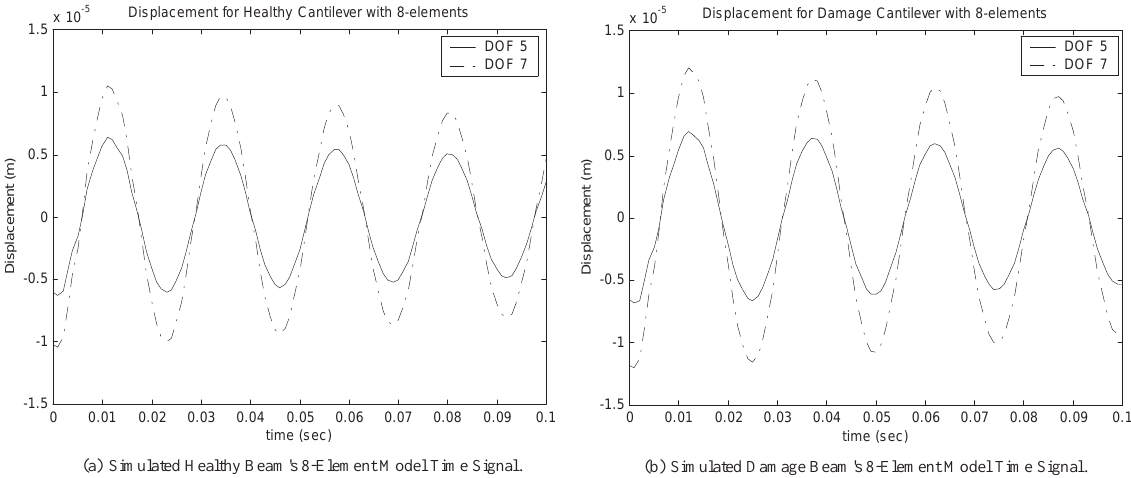
(a) Simulated Healthy Beam's 8-Element Model Time Signal. (b) Simulated Damage Beam's 8-Element Model Time Signal. Fig. 2. Simulated Time Signals from Transient